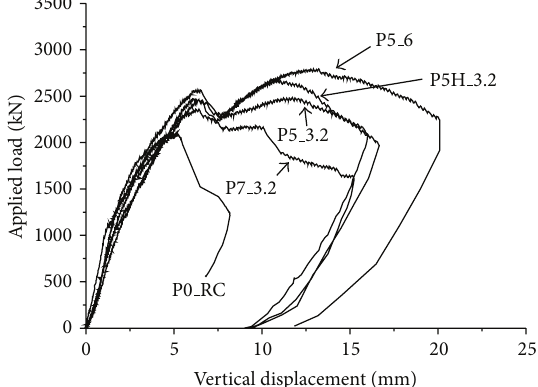
Figure 4: Test setup.